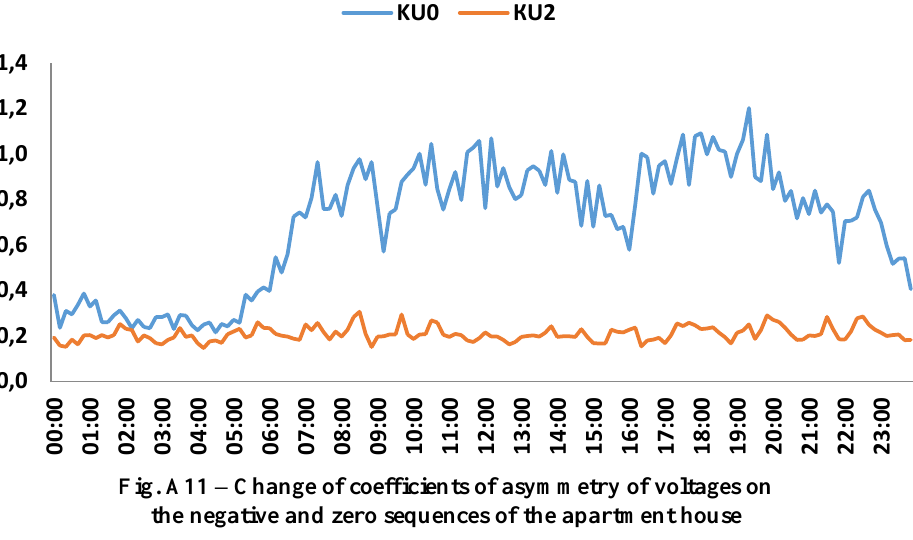
Figure A10 – Change of interphase voltages on input of the apartment house